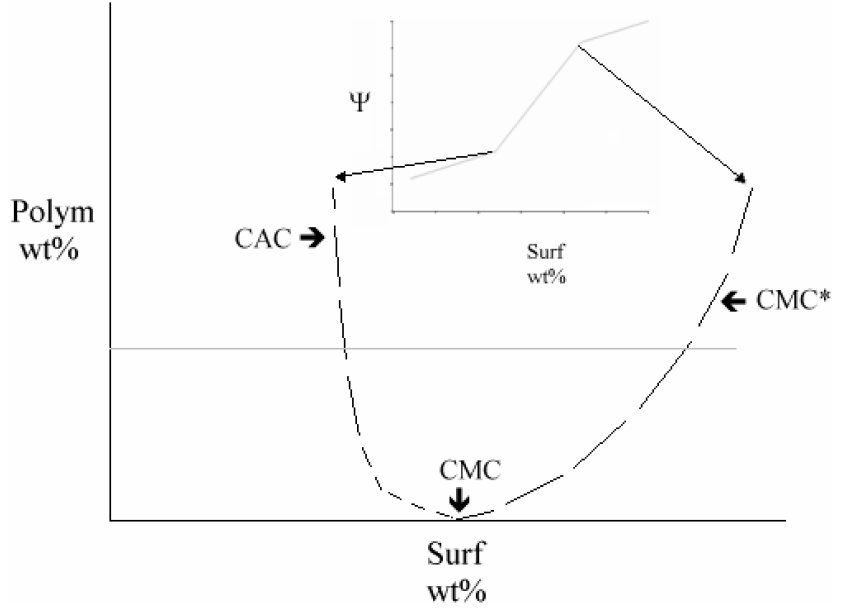
Figure 7. The behavior inherent to polymer-surfactant systems. Critical aggregation, CAC, and critical micellar concentration, CMC*, curves meet at the CMC, indicated in the bottom of figure. In the inset the behavior of a physico-chemical property, Ψ , vs. surfactant content, at fixed polymer wt.% is reported. Two changes in slope occur at the corresponding critical